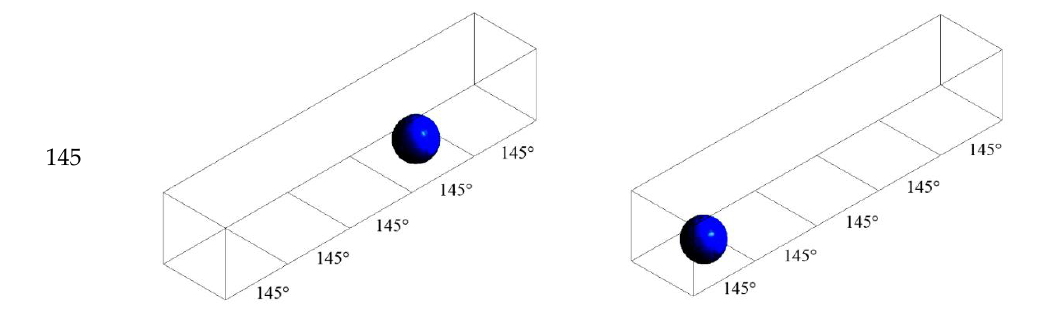
Figure 9. Water droplet dynamics in the flow channel with varied wettability compared with the conventional flow channel (velocity is 0.5 m·s −1 ).